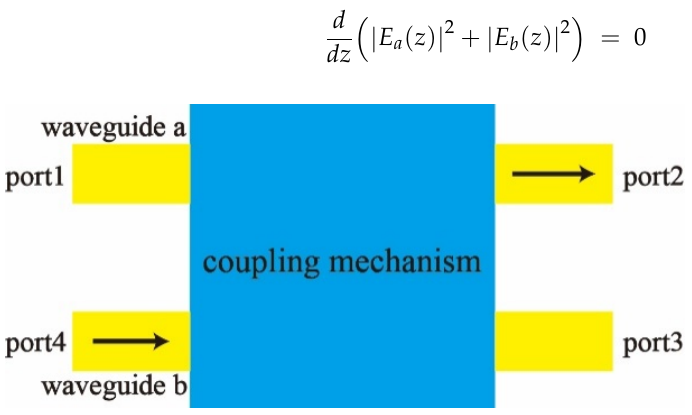
Figure 1. Coupling